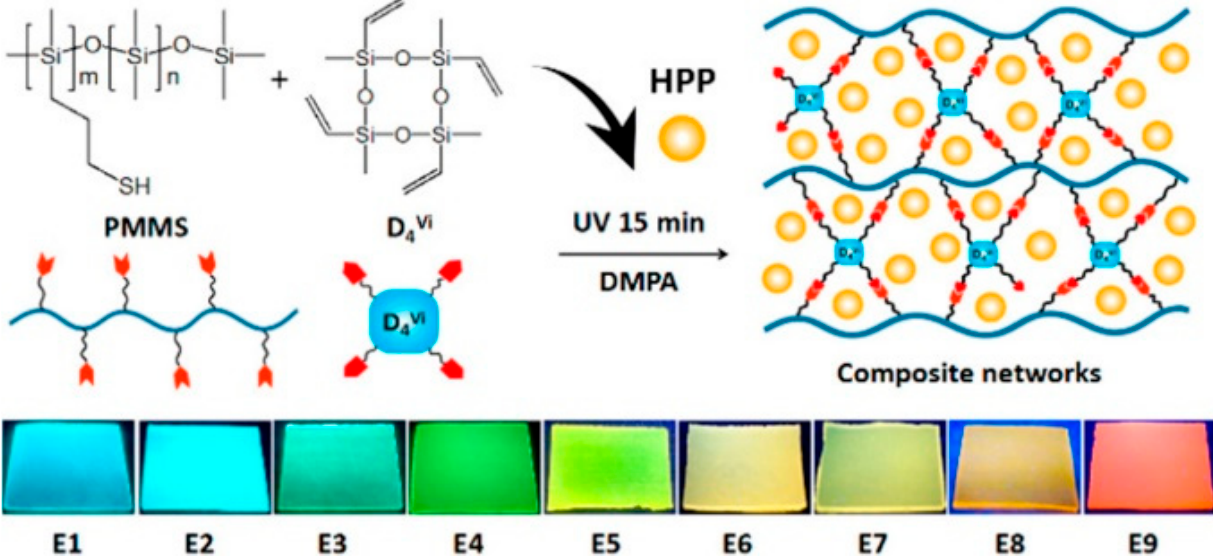
Figure 10. Preparation process of polysiloxane-based fluorescent composites (top). Photographs of the composites doped with hybrid porous polymers (bottom) [68]. Copyright 2018, American Chemical Society.